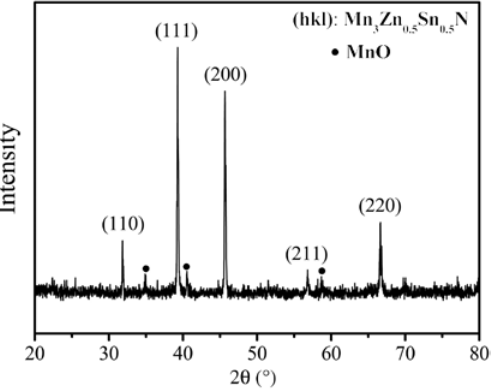
Figure 1: X-ray diffraction pattern of the thermal expansion compen- sator Mn Zn Sn 3 0.5 0.5